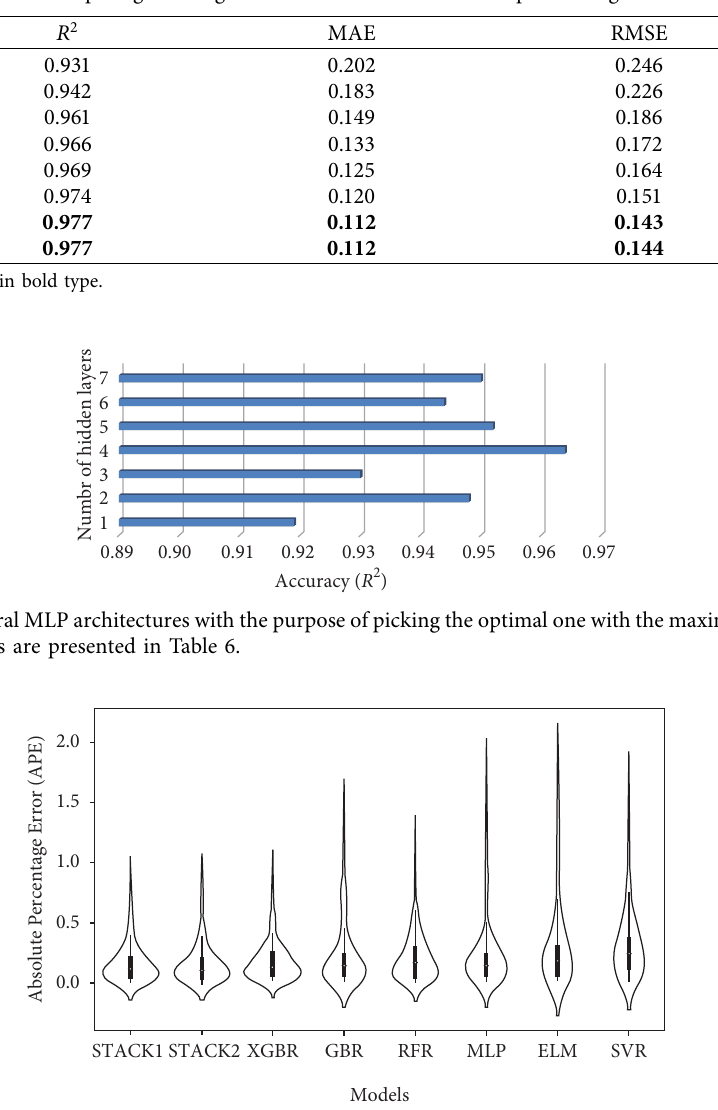
Figure 4: Violin plot to represent the APE of the